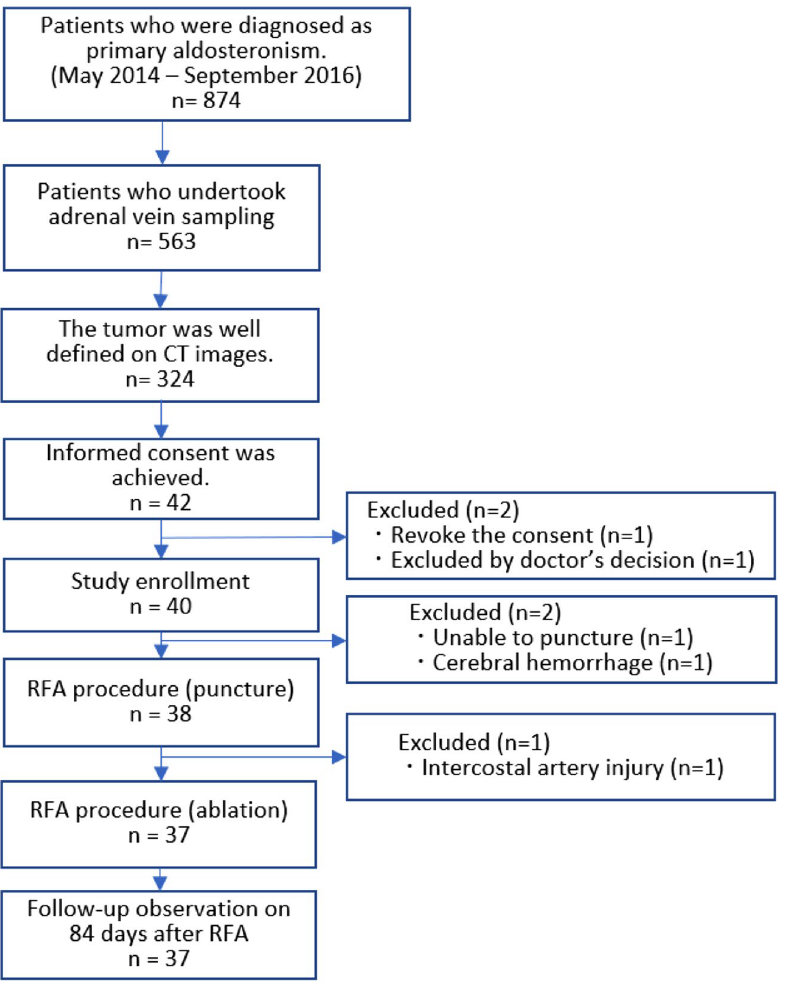
Figure 2. Study flow